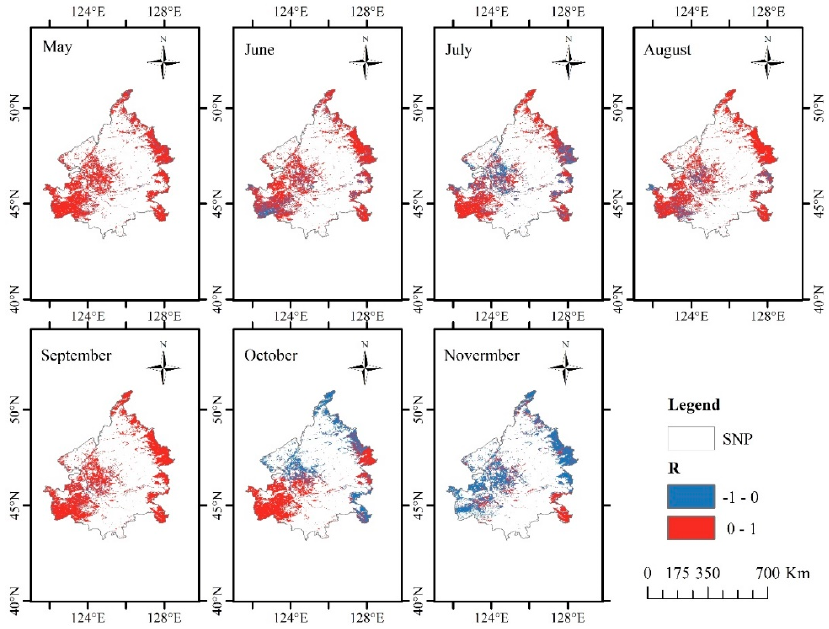
Figure 13. Correlation coefficients between CUE and monthly precipitation.